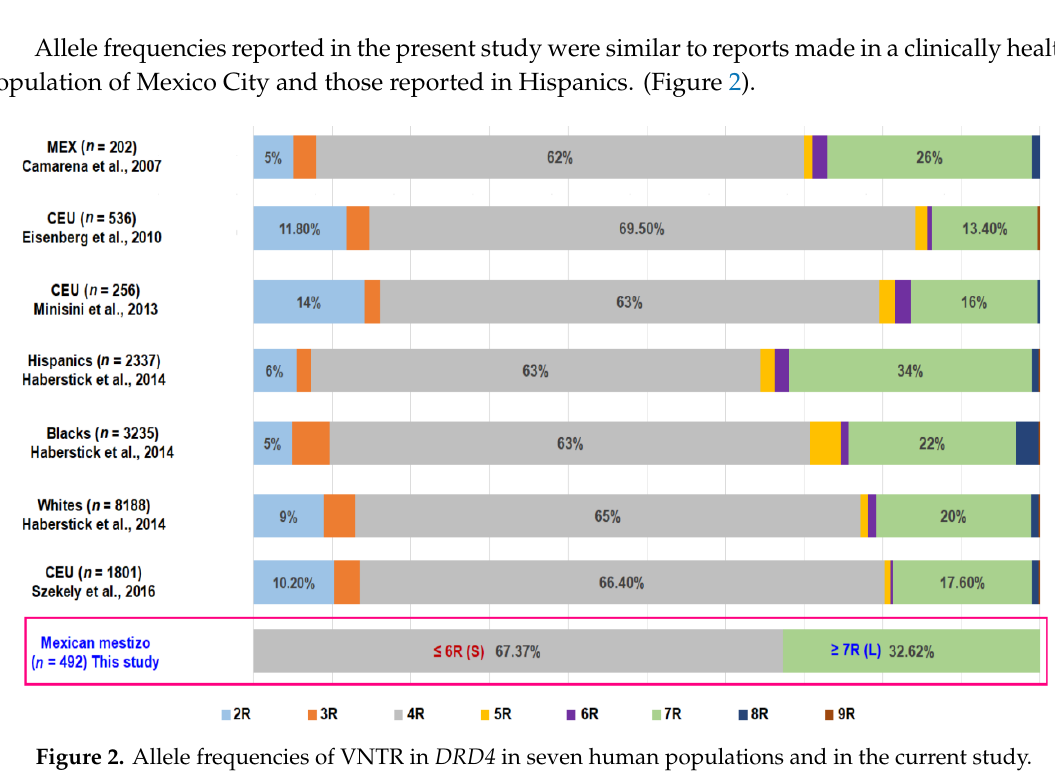
Figure 1. Correlogram between quantitative variables of the three groups included in the study, showing Spearman’s rho. * p < 0.05. ** p ≤ 0.01. FEV 1 , FVC, and FEV 1 /FVC values are shown post-